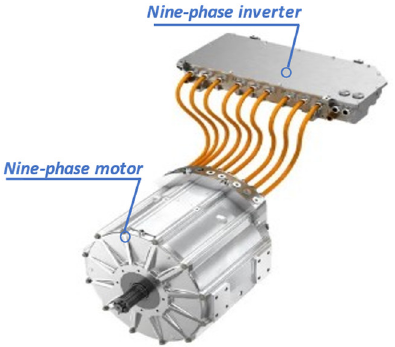
Figure 30. DANA TM4 SUMO TM HD nine-phase drive [161].